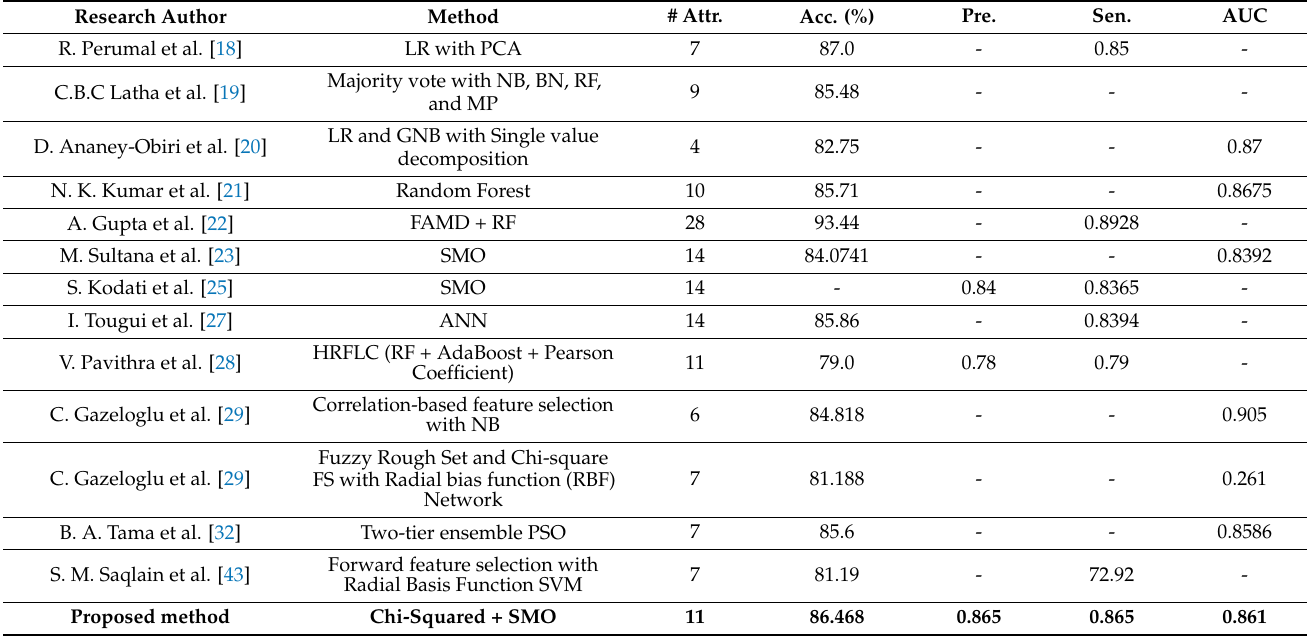
Table 13. Performance comparison of related